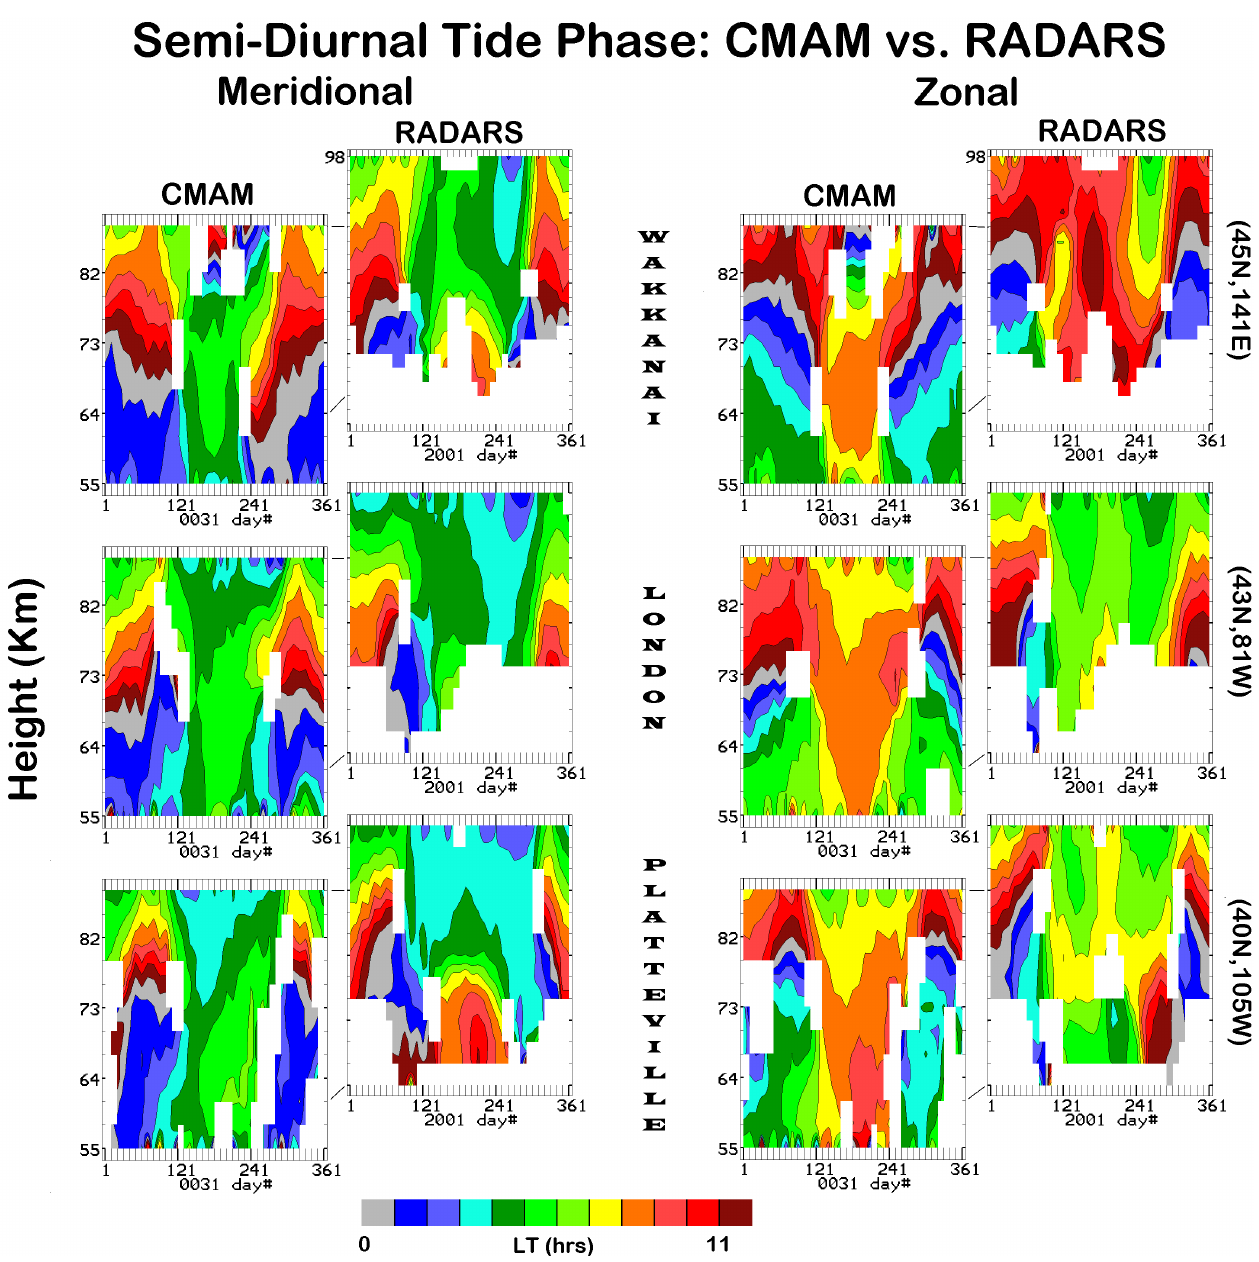
Fig. 8. Annual contour plots (height versus time) of semi-diurnal (12-h) tidal phases for the three CUJO network locations near 45 ◦ N, from both the MF radar observational systems and from CMAM. Zonal (EW) and meridional (NS) components are